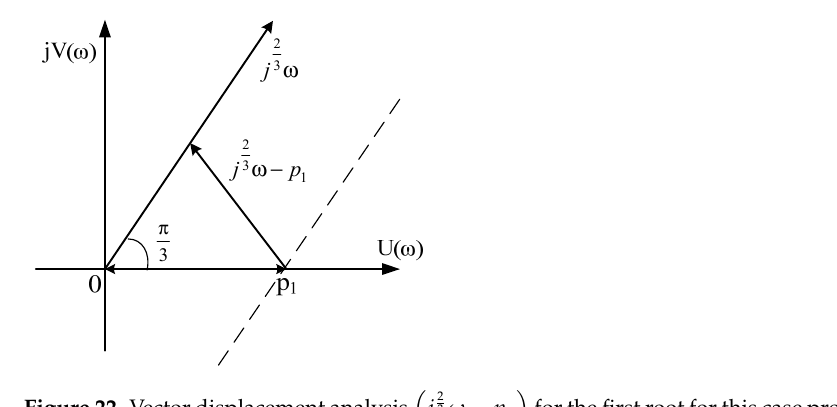
Figure 22. Vector displacement analysis (𝑗 𝜔 𝜖 (0, ∞)